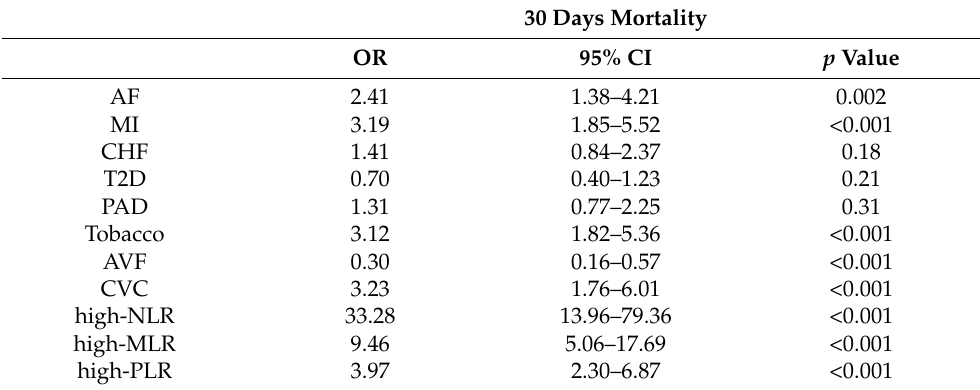
Table 6. Multivariate analysis on 30 days mortality occurrences during the entire study